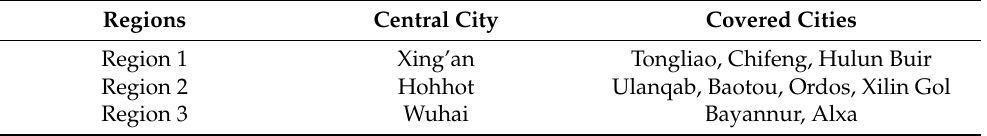
Table 4. The clustering results for the optimal k . Regions Central City